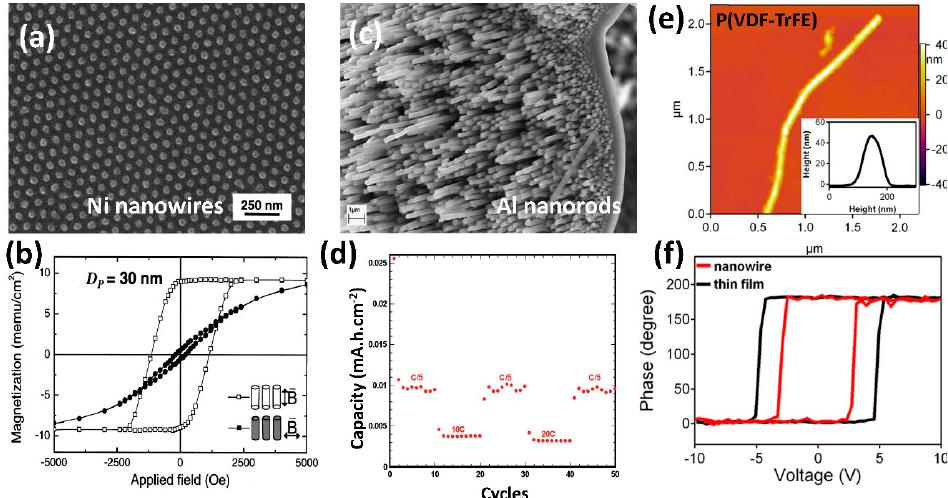
Figure 2. ( a ) SEM image of Ni-filled AAO template; ( b ) hysteresis loops for Ni nanowires